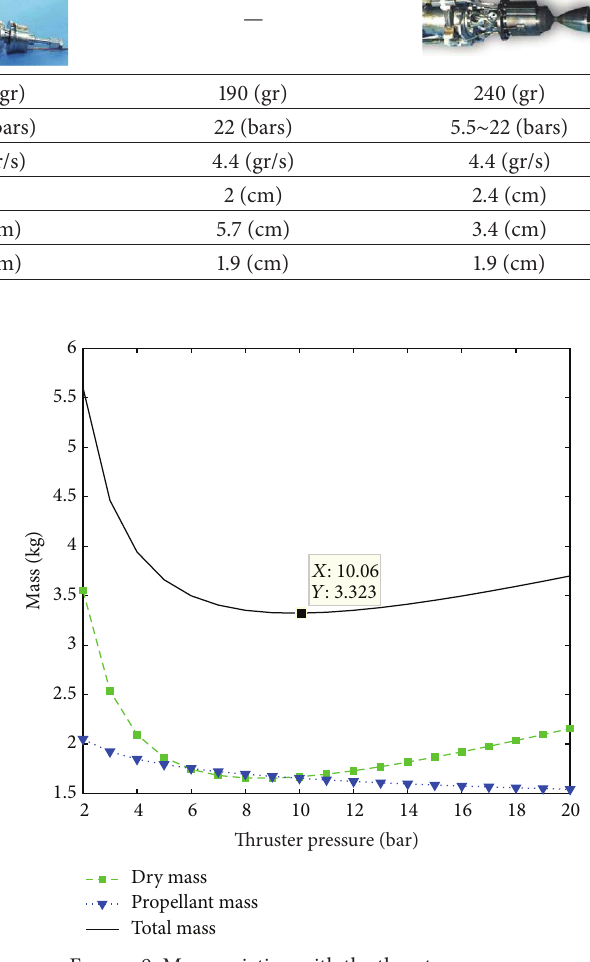
Figure 9: Mass variation with the thruster